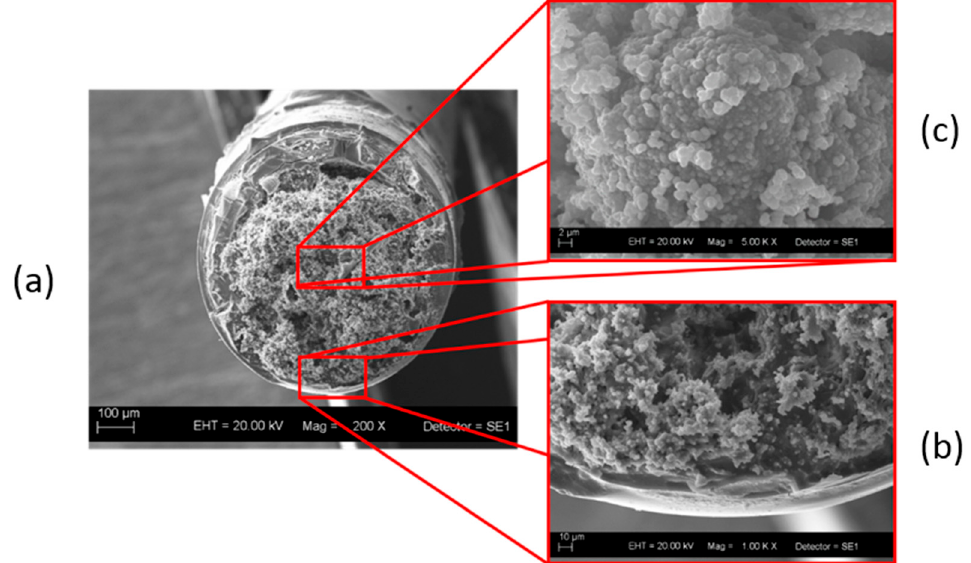
Figure 2. Scanning electron microscopy images of hybrid silica monolith containing cyanopropyl and